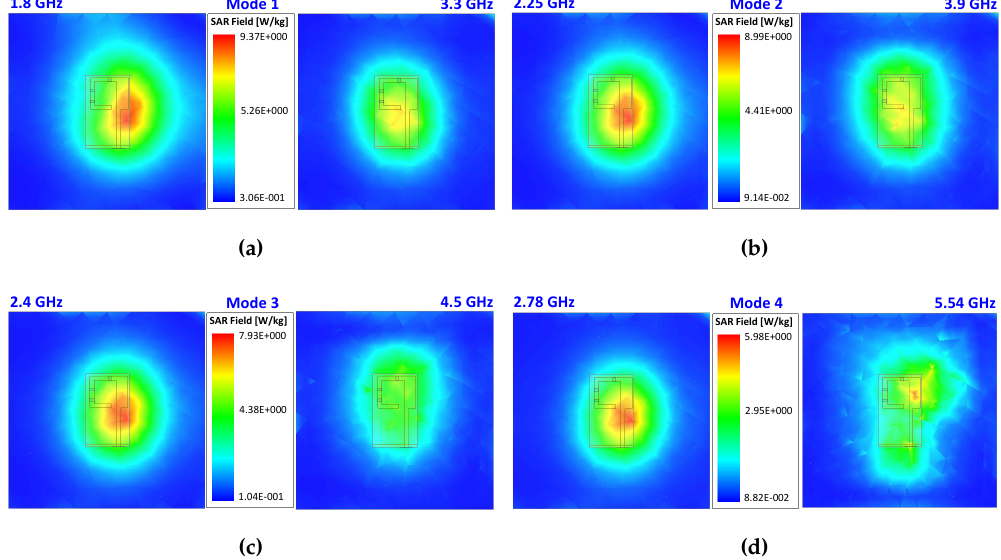
Figure 8. Simulated specific absorption rate (SAR) of the antenna: ( a ) Mode 1; ( b ) Mode 2; ( c ) Mode 3; and ( d ) Mode 4. Table 2. Summary of the simulated antenna under different operating modes.